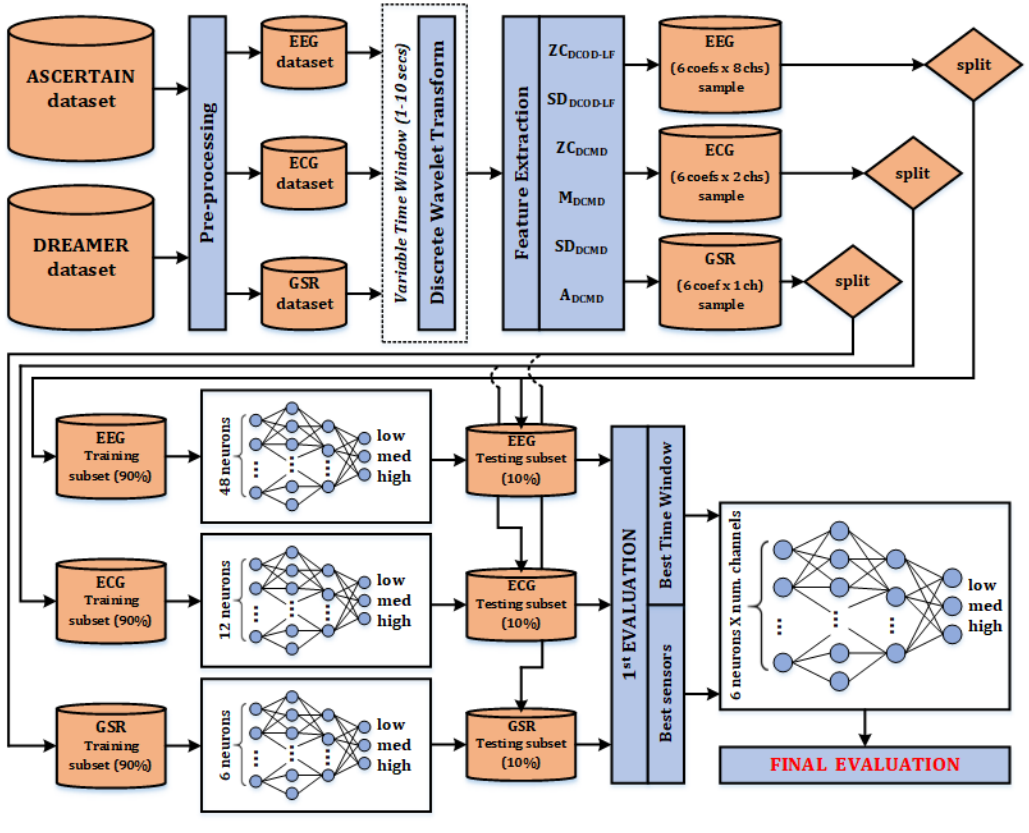
Figure 2. Full system implemented in this